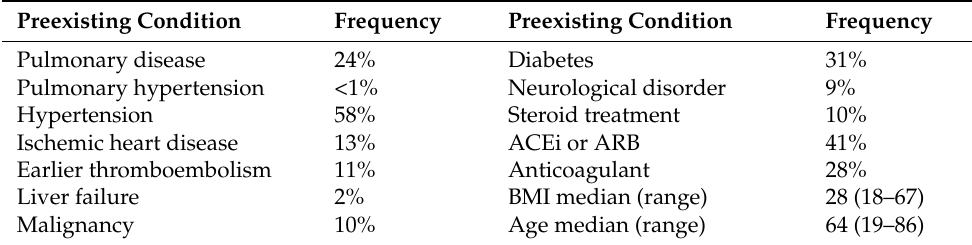
Table 2. Patient demographic characteristics and